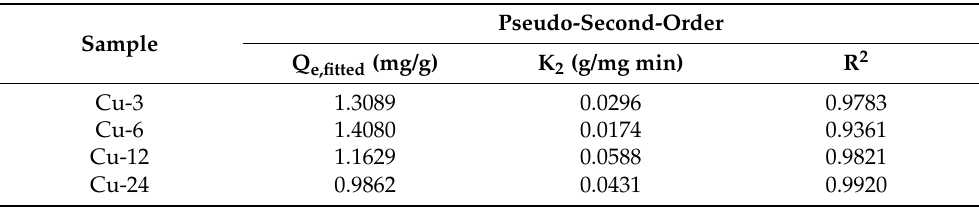
Table 2. Adsorption kinetic parameters of MB by the nanocomposites obtained using the pseudo- second-order kinetic Equation